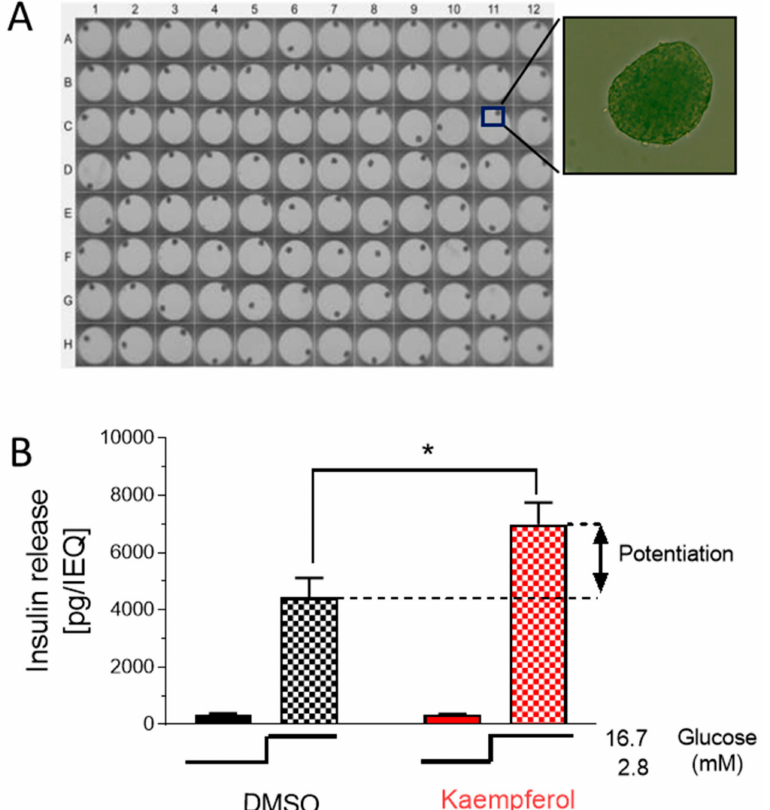
Figure 6. Kaempferol potentiates glucose-stimulated insulin secretion in human pseudo-islets. ( A ) Single isolated human pseudo-islets in 96-well plates. ( B ) Glucose-stimulated insulin secretion of human pseudo-islets exposed to low glucose (2.8 mM, n = 6) or high glucose solution (16.7 mM, n = 12) in combination with either DMSO 0.1% (black) or 10 µ M kaempferol (red). Shown is the mean ± SEM. Statistical analysis was performed by ANOVA test (*, p <